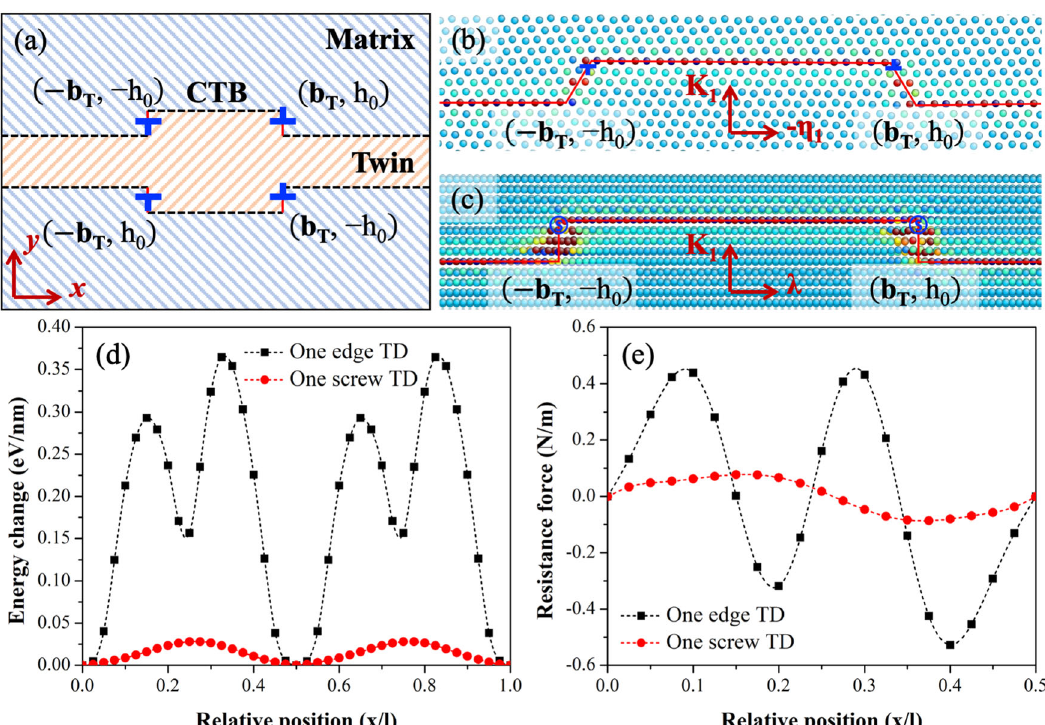
Fig. 2 Structures and kinetics of single TD. a Schematics showing TDs along CTBs. b Atomic structure of a pure edge TD dipole in BS view . c Atomic structure of a pure screw TD dipole in DS view. d The change of potential energy associated with the migration of an edge TD and a screw TD. e The resistance force associated with the migration of an edge TD and a screw